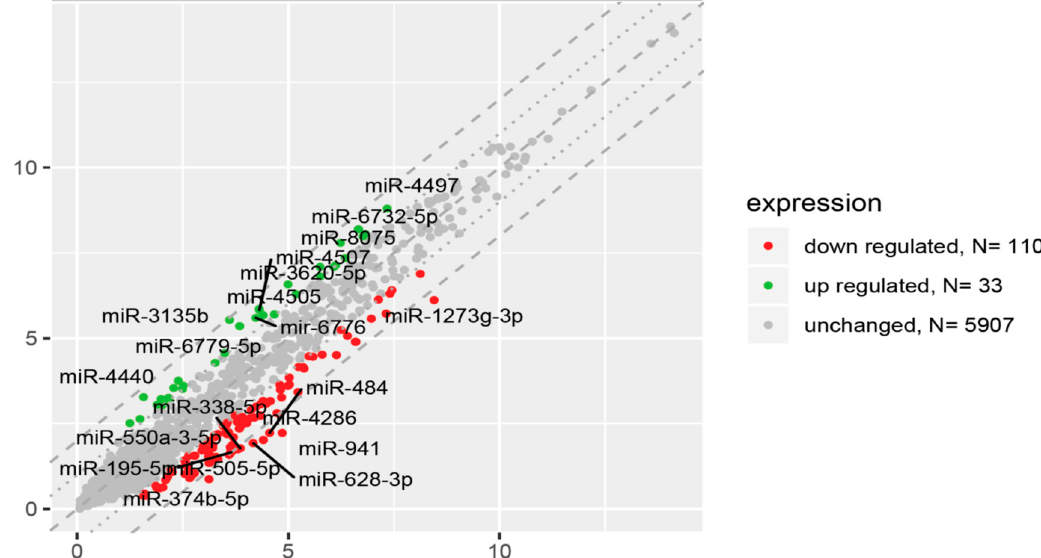
Figure 2. The scatter plot of global miRNA expression in UCB from preterm neonates when compared to term ones. Red points show downregulated miRNAs (at least 2-fold change, p < 0.05), green points show upregulated miRNAs (at least 2-fold change, p < 0.05). The graphs also comprise the names of miRNAs with the largest change in expression. On the vertical axis (y-axis) are plotted data from preterm group in this study. On the horizontal axis (x-axis) are plotted data from termly delivered neonates, which serve as the control group in this study. Table 2. The profile of cellular miRNA up-regulated in preterm newborns in comparison with control full-term neonates (the fold di ff erence). No. miRNA Name miRNA Type Absolute Fold